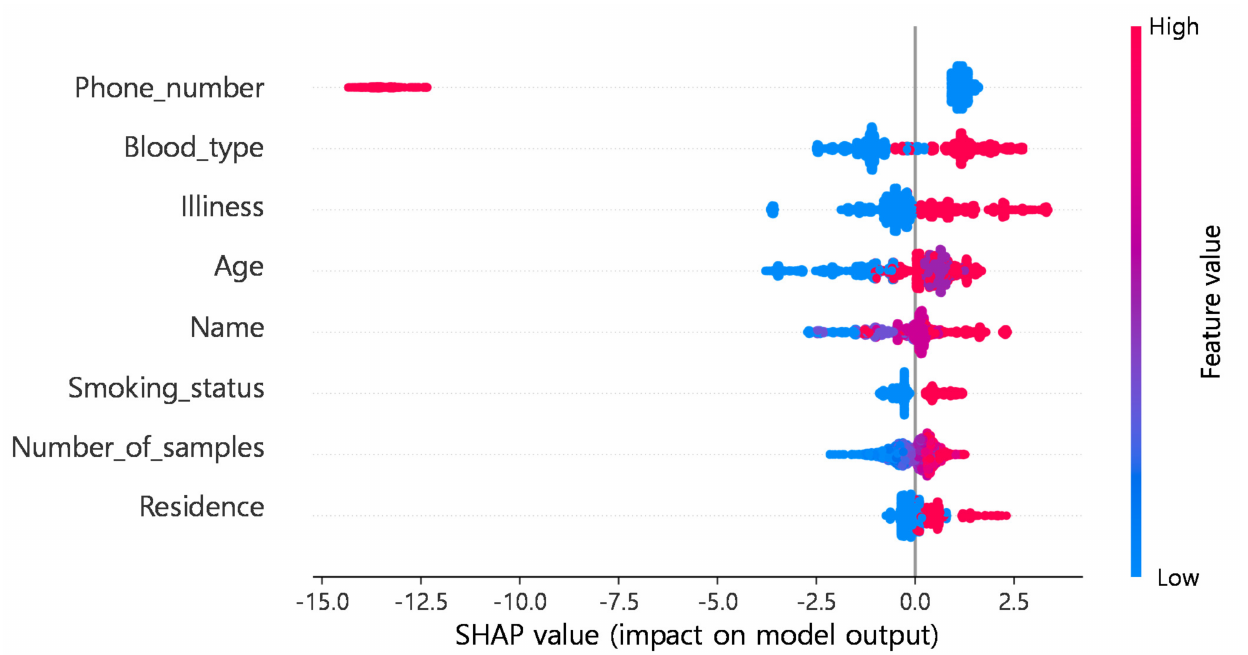
Figure 5. Sample Shapley additive explanation force plot for final score prediction.